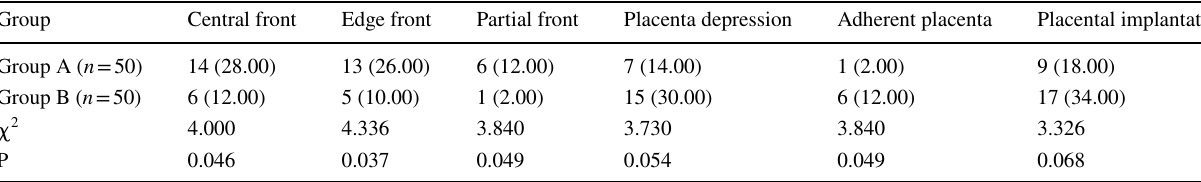
Table 2 Comparison of detection rates of disease types between the two groups [n/%] Group